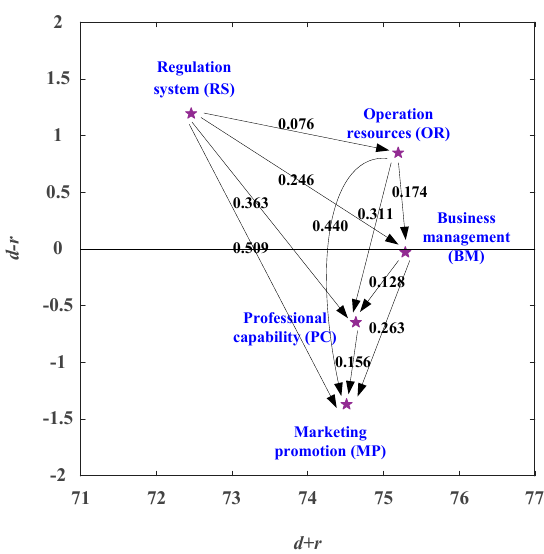
Figure 2. The NRM (Network Relation Map) for urban sustainable development.